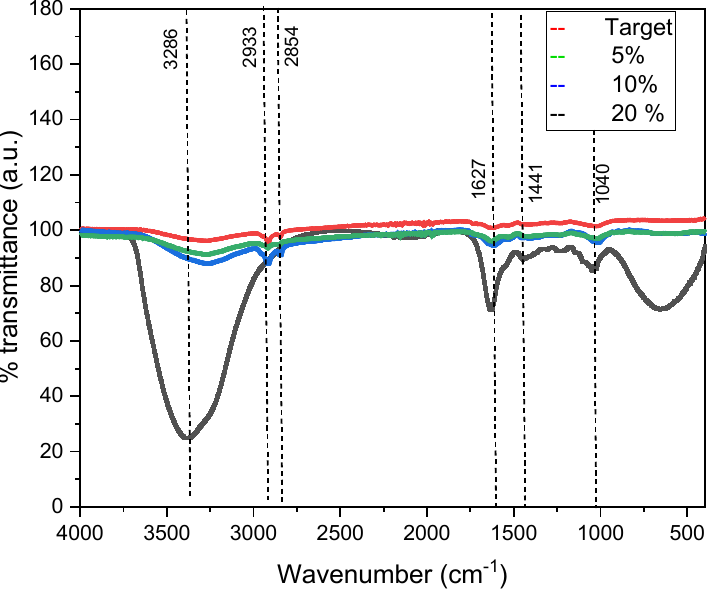
Figure 4. FTIR spectrophotometry of the tomato residues with